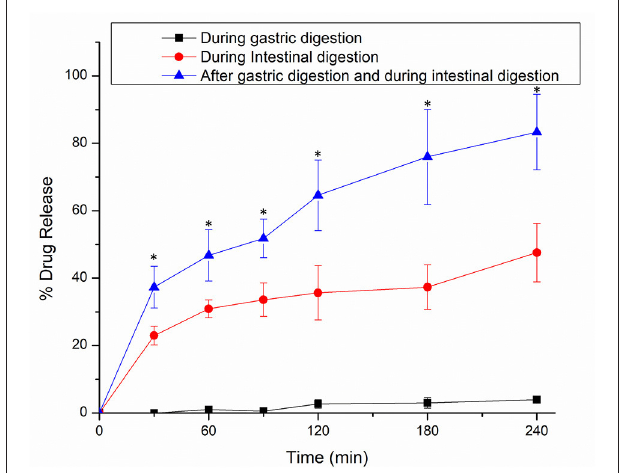
FIGURE 7 | In vitro release profiles of thymoquinone from alginate-chitosan hydrogel beads immobilized Pickering emulsion in SGF, SIF, and 2h in SGF followed by SIF. Error bars represent the standard deviation of three replicates. *Marks significant differences ( p < 0.05). A comparison was made between 2h in SGF followed by SIF and SGF/SIF.